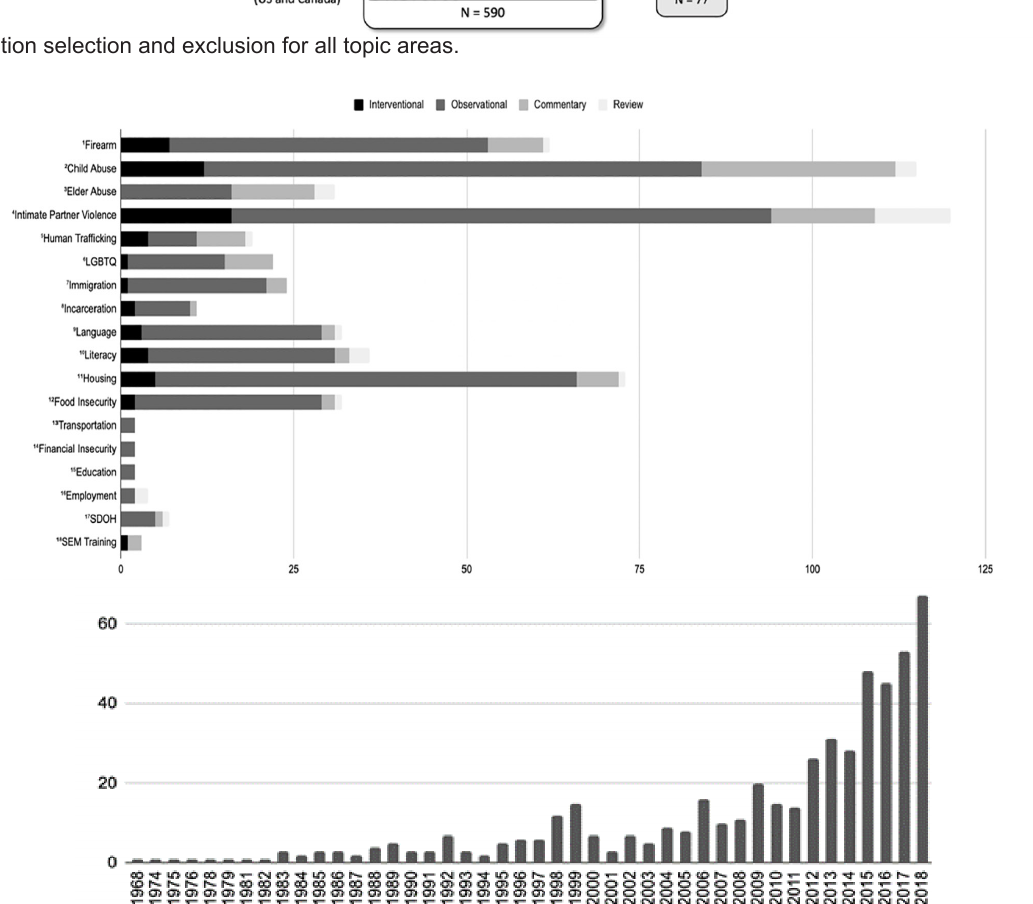
Figure 2. Summary of results across all categories by article type and number of publications by